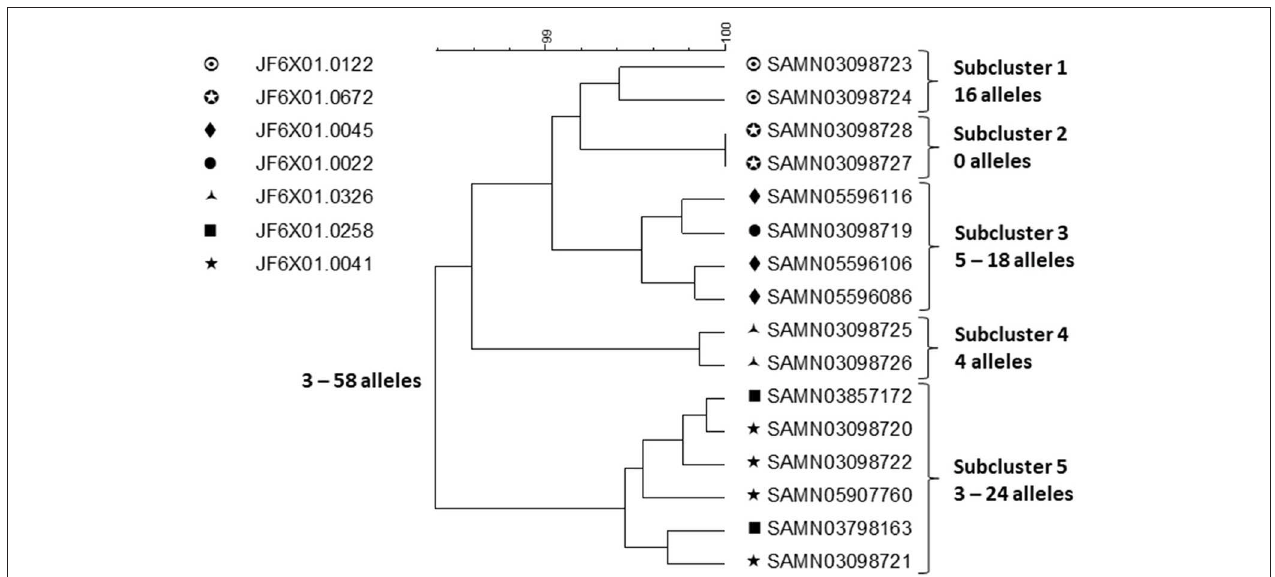
FIGURE 2 | cgMLST UPGMA tree of a representative sample of sequences of Salmonella ser. Heidelberg isolates displaying the full WGS diversity and representing the seven PFGE patterns from the outbreak associated with chicken produced by Company A. The range of allele differences are indicated at the branches of the tree and subclusters to the right of the